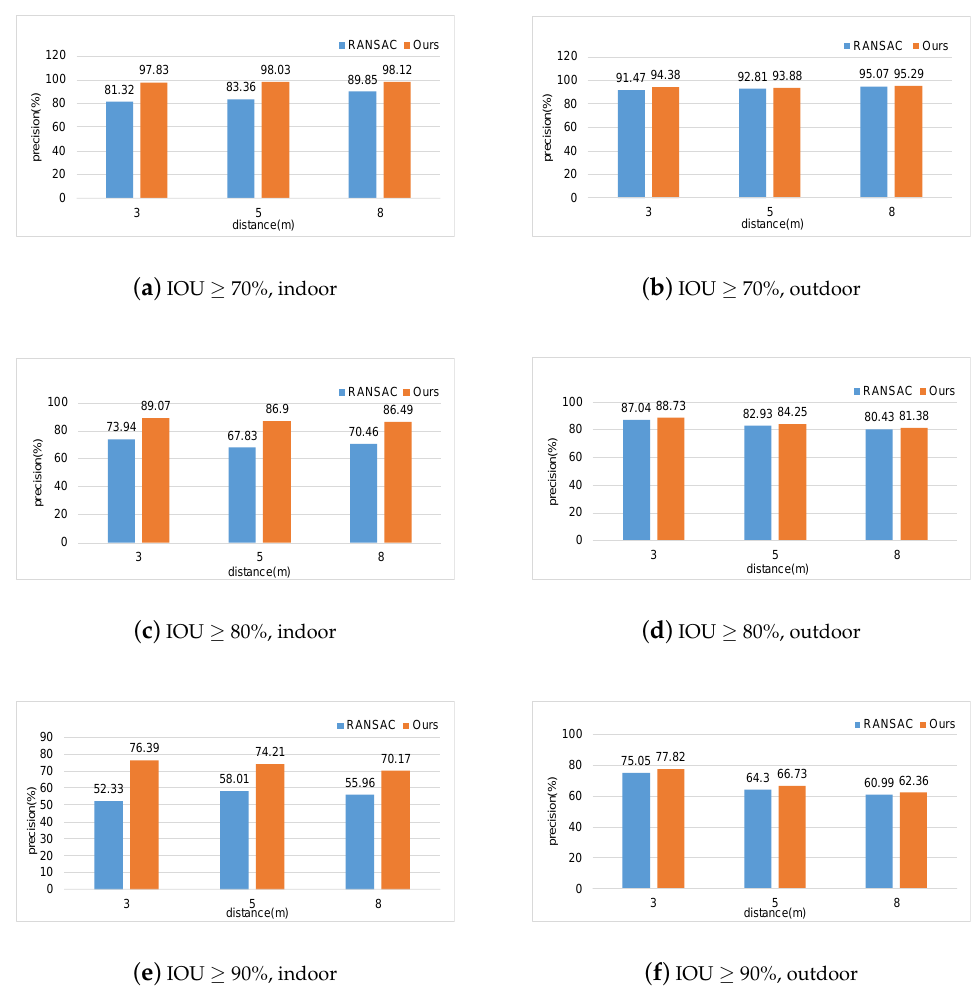
Figure 11. Precision of ground segmentation in different measuring distance and different IOU.